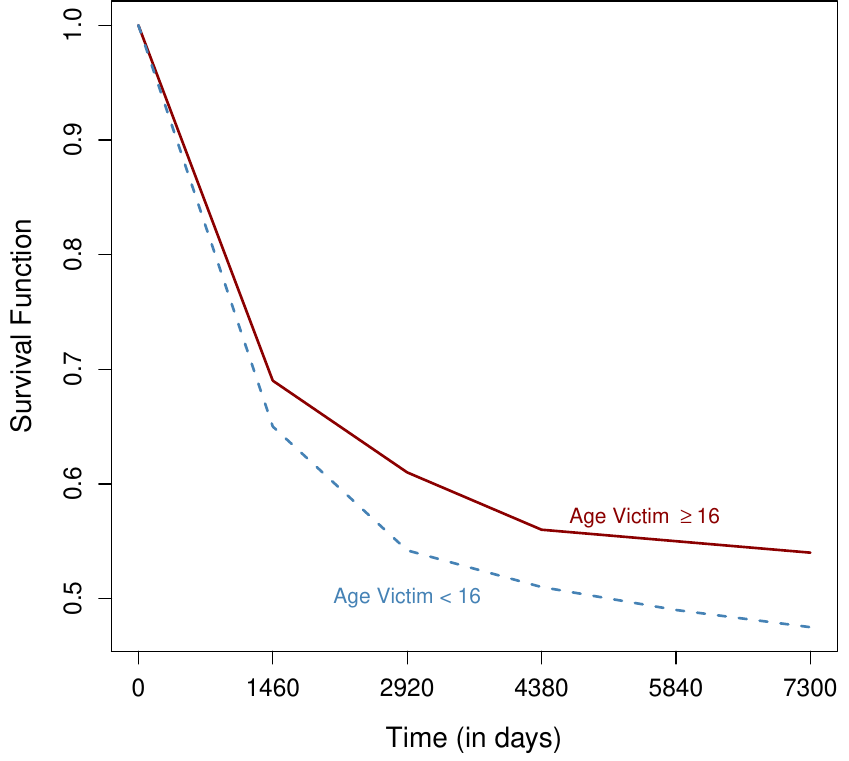
Figure 1. Dependence of the survival function of the age of the